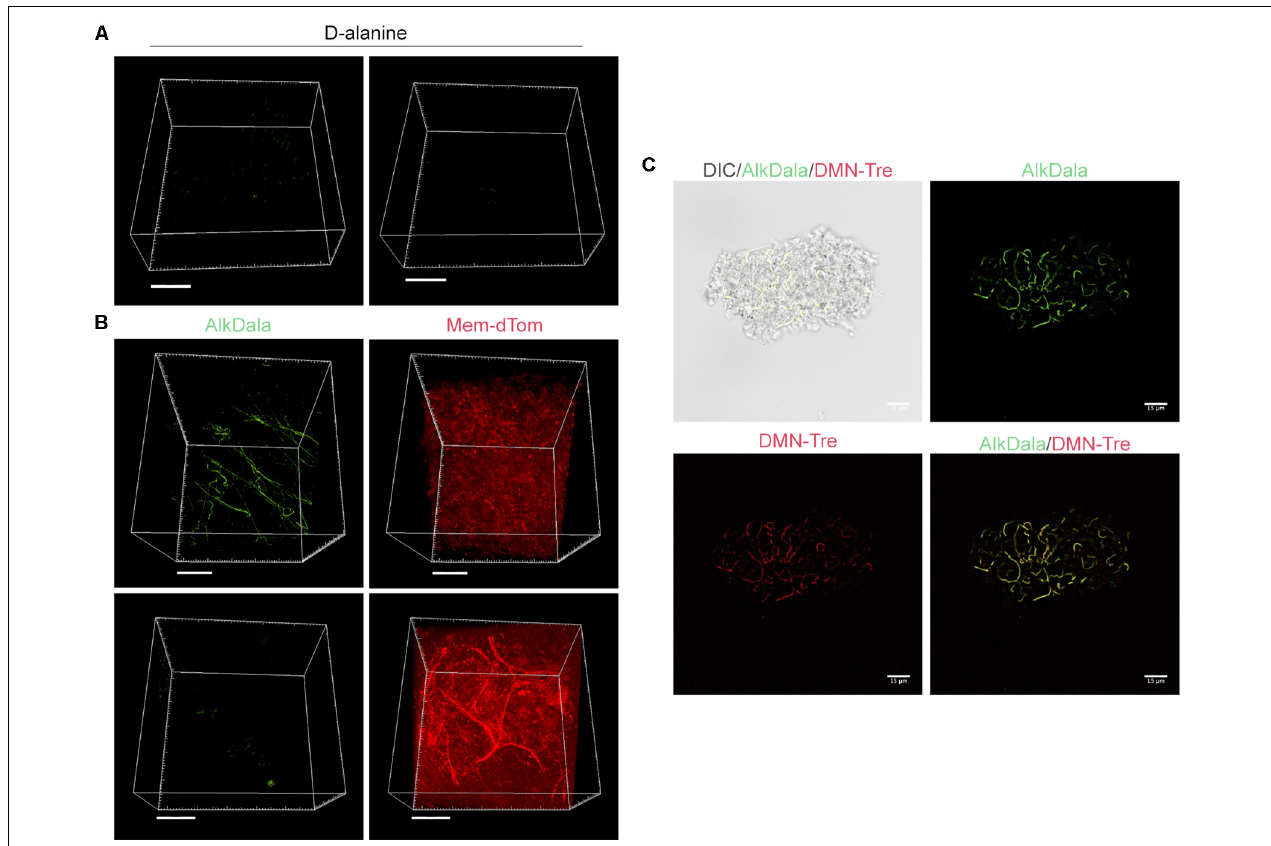
FIGURE 3 | Filamentous structures identified on conjunctiva are not host tissue. (A) Mouse eyes incubated in D -alanine, without an alkyne, resulted in no fluorescent labeling. (B) Wild-type transgenic mice with fluorescent red cell membranes mT/mG knock-in mice (Muzumdar et al., 2007) were used in conjunction with alkDala labeling to determine if the filaments identified on the conjunctiva colocalized with host tissue. Filamentous structures on the conjunctiva (Upper) did not colocalize with host cell membranes (denoted Mem-dtom). Conversely, when filament-like structures were present in host tissue, alkDala labeling was not present (Lower) . Images shown on the left and right are of the same fields of view with different emission filters. (C) Imaging of murine conjunctival epithelial tissue shows that DMN-Tre, a probe specific for Corynebacterineae (red), labeled most of the same conjunctival forms as alkDala (green). All images are from the same field of view with different emission